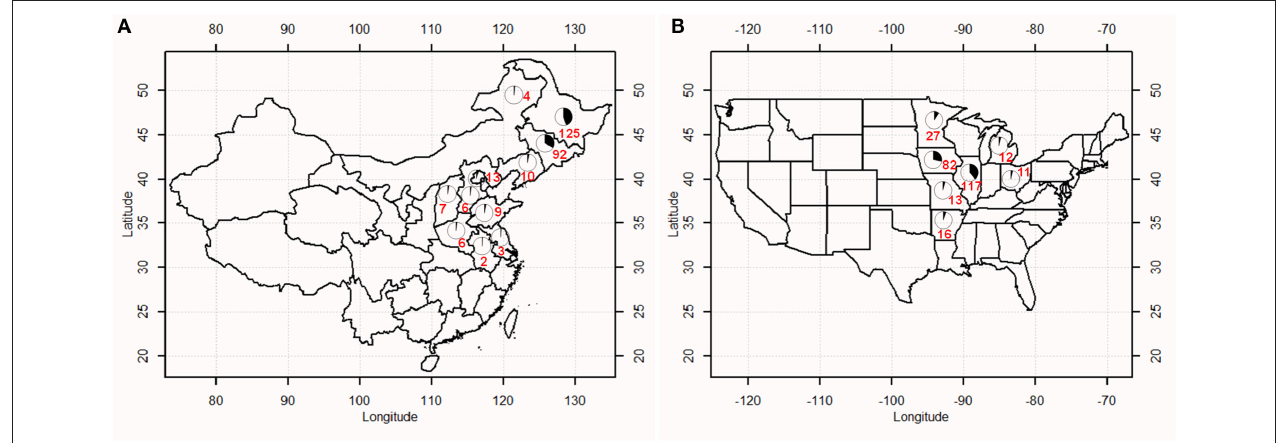
FIGURE 1 | Geographic distribution of soybean accessions in China (A) and the USA (B) . Numbers marked on the map indicated the number of accessions from a given